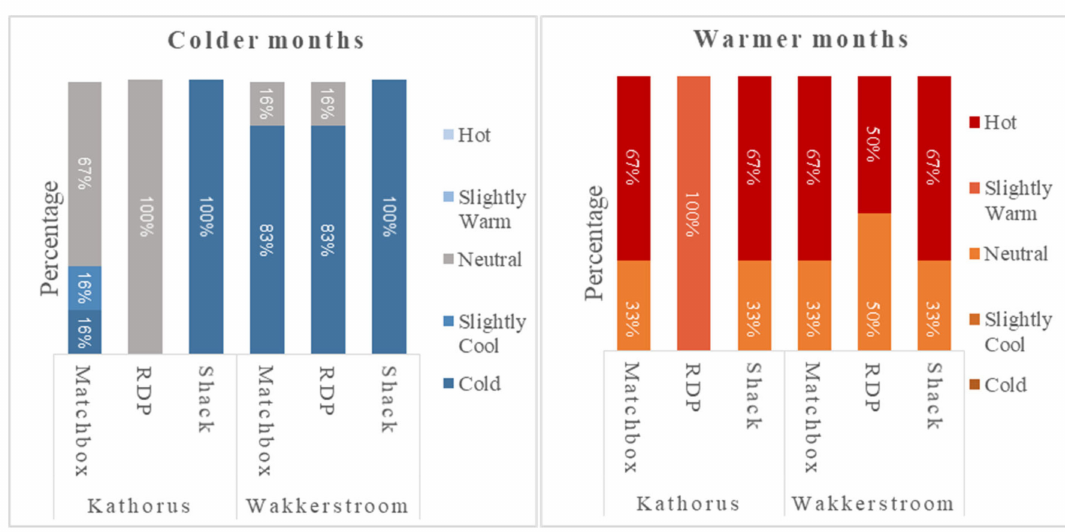
Figure 15. Self-reported perception of thermal comfort during warmer and colder months in Kathorus and Wakkerstroom area (n =